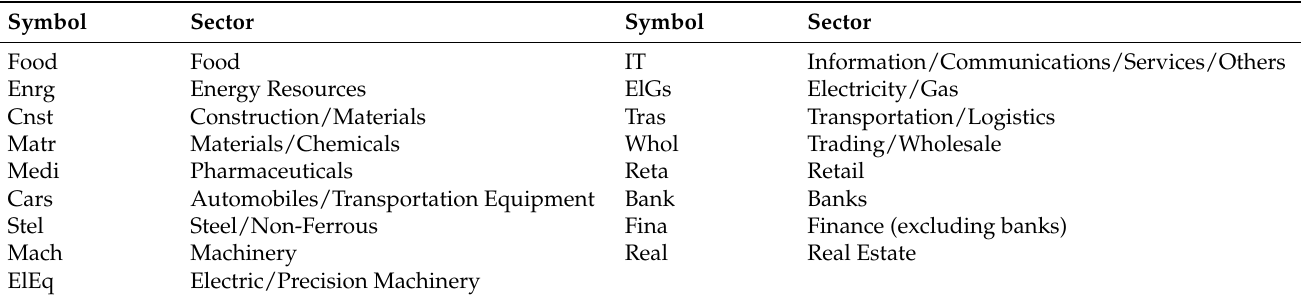
Table 1. Sectors included in the TOPIX-17 series and their